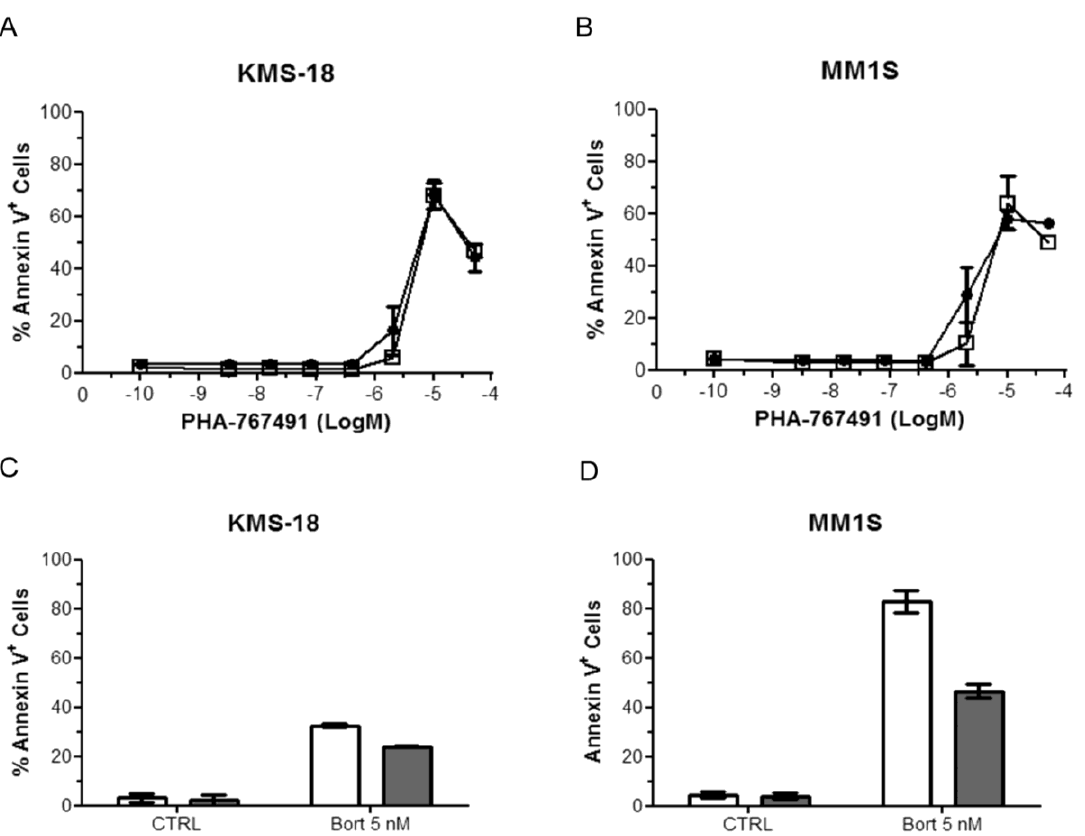
Figure 5. PHA-767491 induces apoptosis in KMS-18 and MM1S in co-culture with HS5 cells. KMS-18 ( A ) and MM1S ( B ) cells were cultured with (open square) or without (black circle) HS5-H2B-GFP cells for 2 h and then treated with different doses of PHA-767491 for a further 24 h. Apoptosis was assessed by AV staining. In parallel samples, KMS-18 ( C ) and MM1S ( D ) cultured with (gray bars) or without (white bars) HS5-H2B-GFP cells for 2 h, were treated with 5 nM bortezomib and apoptosis was analysed 24 h after treatment using AV staining. Data are presented as mean ± standard deviation of two independent repeats. The M in the x axes defines